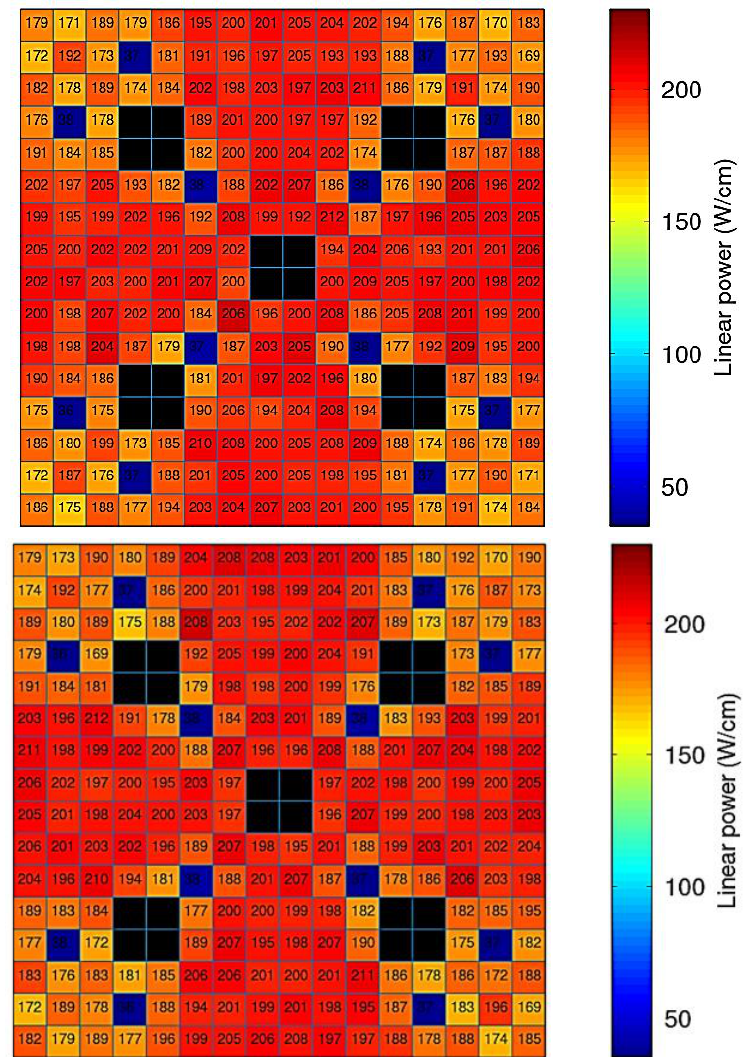
Figure 8. Pin power distribution at BOC comparison between reference cladding and coated cladding 10 µm, 15 µm, and 20 µm, respectively, for b1 fuel assembly.